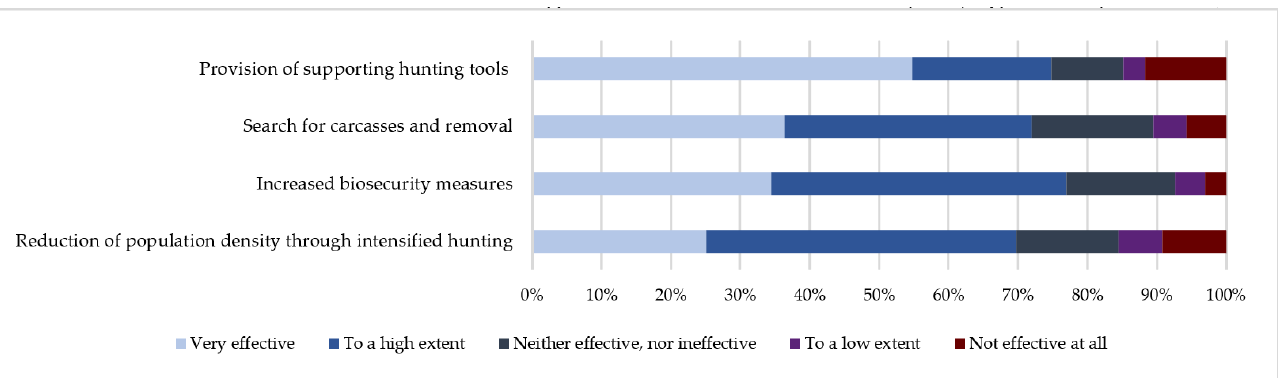
Figure 1. The most effective measures to eliminate ASF in wild boar population perceived by Lithuanian hunters responding to the anonymous survey.